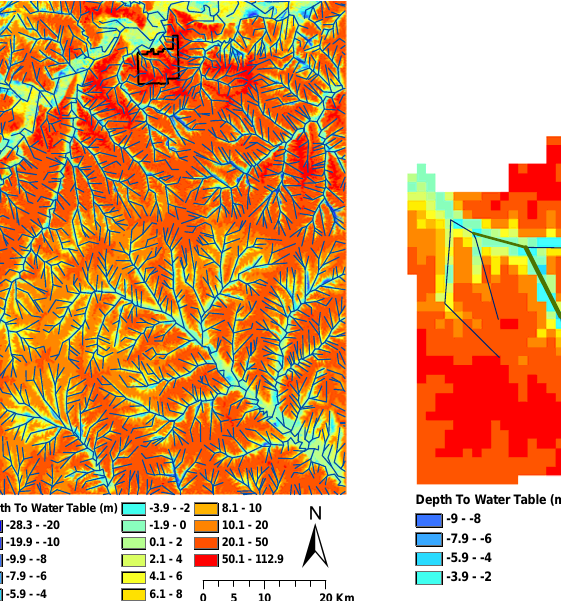
Fig. 8. Depth to water in the study region and at Konza LTER.